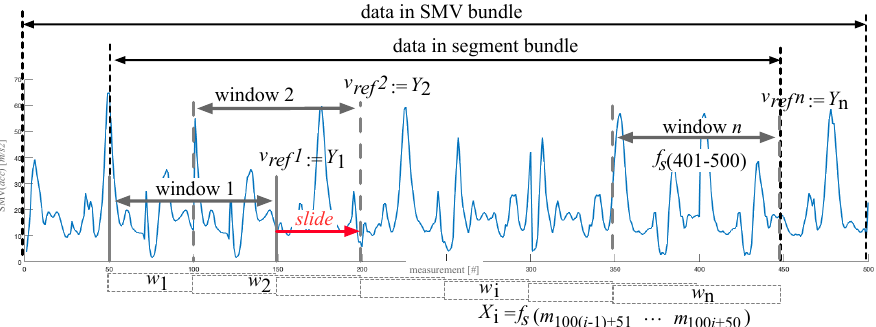
Figure 2. Exemplary cutout of a segment that shows an SMV ( acc ) of a single walking activity. We slice windows from a clean segment and calculate the reference velocities at the end of each